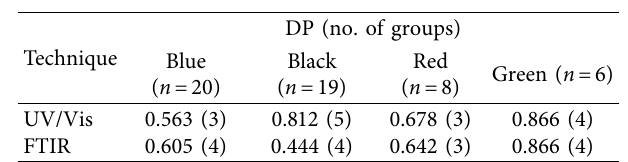
Table 2: DP for UV/Vis and FTIR of blue, black, red, and green ballpoint inks calculated by visual analysis.